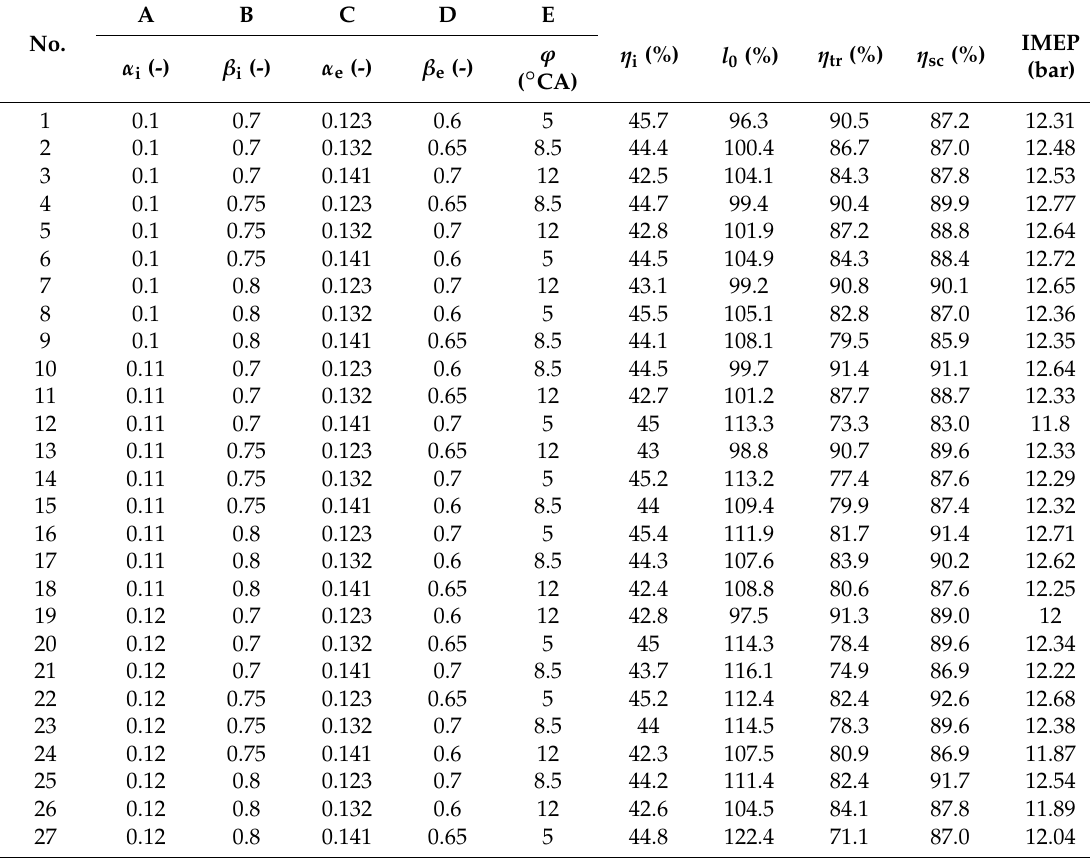
Table 2. Calculation scheme and